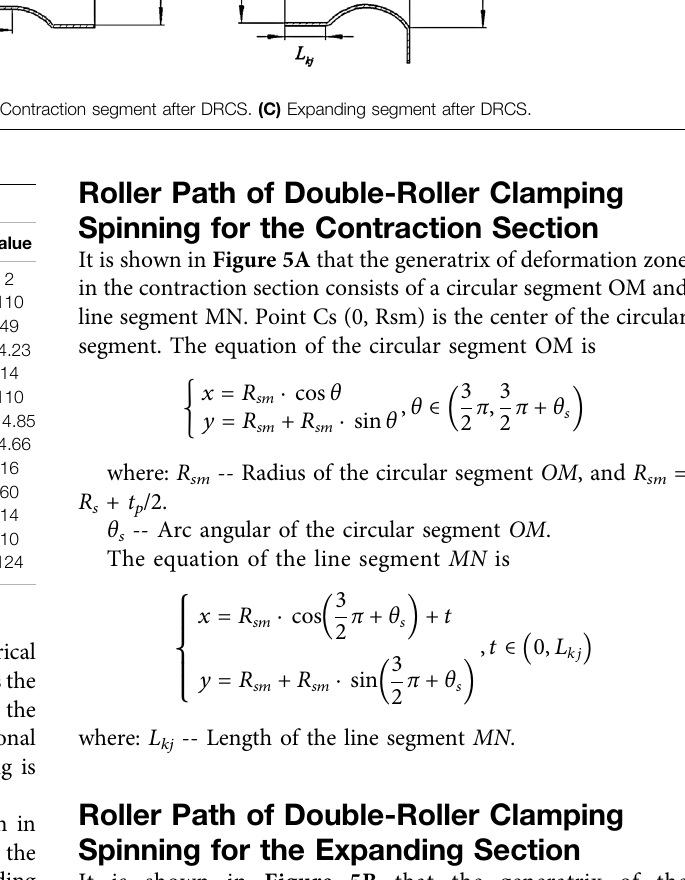
Frontiers in Energy Research |